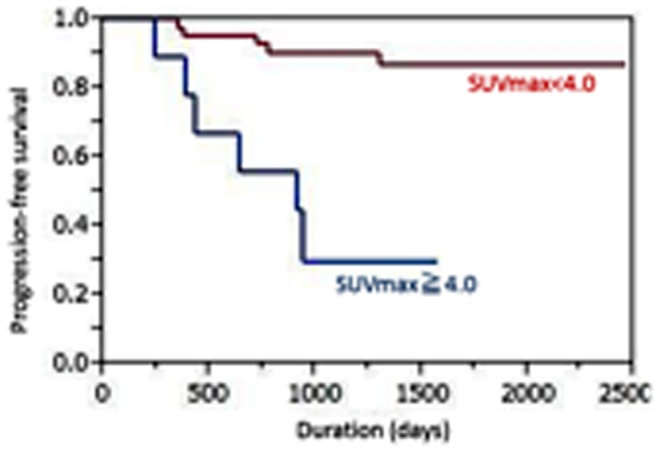
The high SUVmax (≧4.0) subgroup showed a significantly shorter median progression-free survival time than the low SUVmax (<4.0) subgroup (30.4 vs. 52.2 months; p<0.0001).